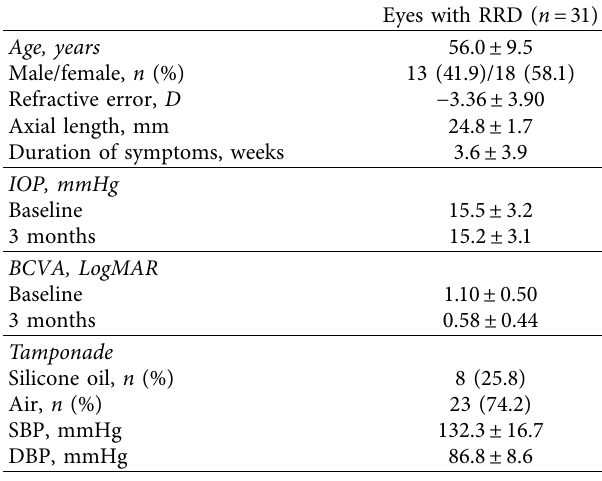
Table 1: Demographics characteristics for the study subjects.